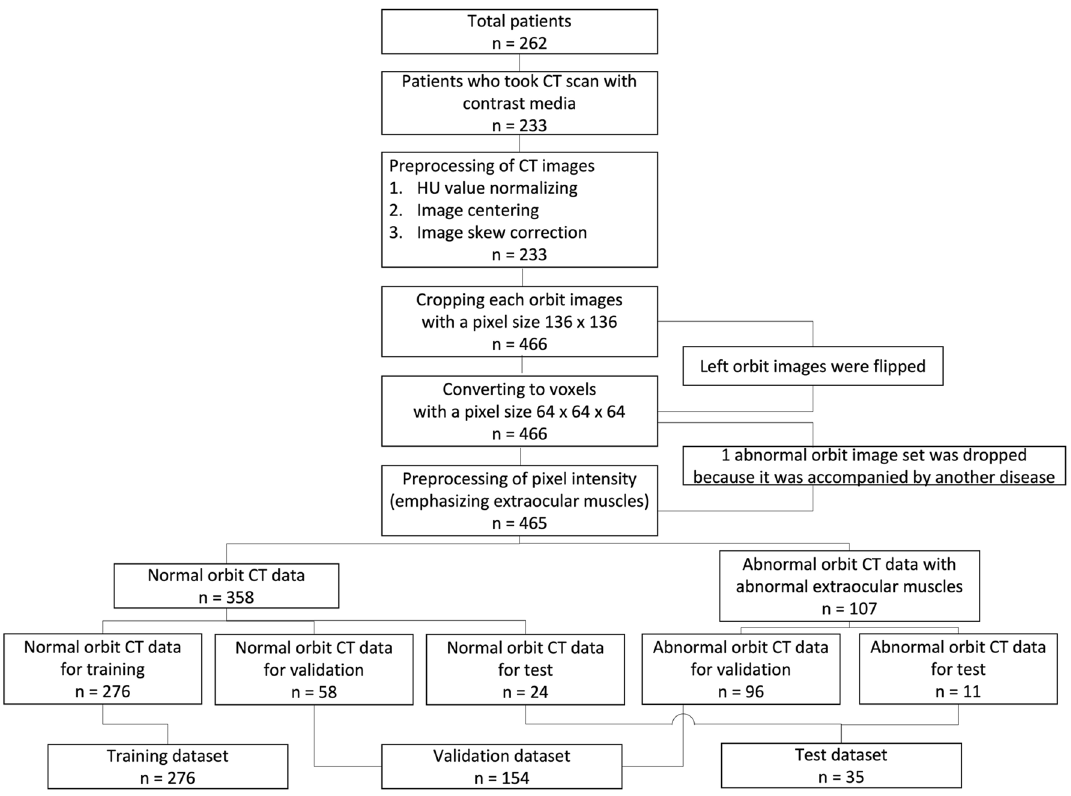
Figure 8. The sequential flow of preprocessing. CT Computed tomography, HU Hounsfield